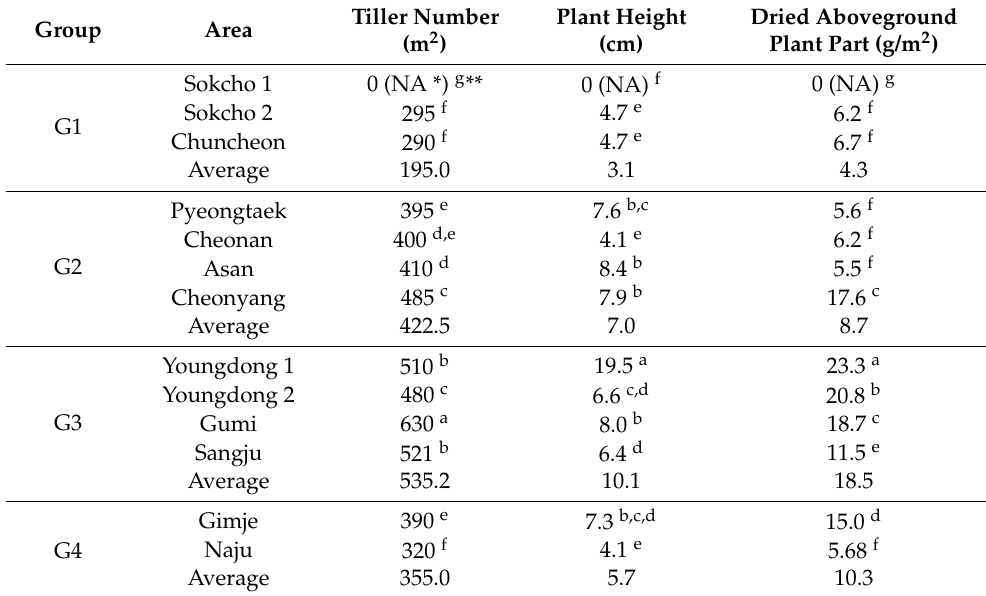
Table 1. Growth of dehulled barley plants in different group areas before overwintering (December). Tiller Number Plant Height Dried Aboveground Group Area (m 2 ) (cm) Plant Part (g/m 2 ) Sokcho 1 0 (NA *) g ** 0 (NA) f 0 (NA) g Sokcho 2 295 G1